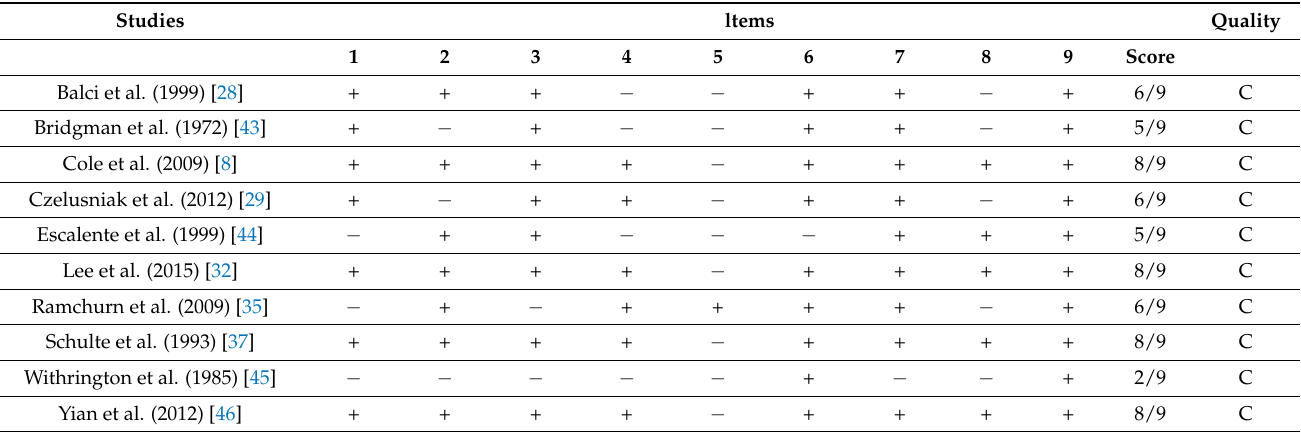
Table 3. Methodological assessment using specific criteria described in the AHRQ to assess the risk of bias for benefits for cross-sectional